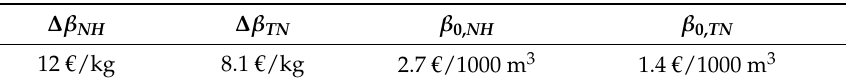
Table 1. Costs associated when discharge limits are exceeded.